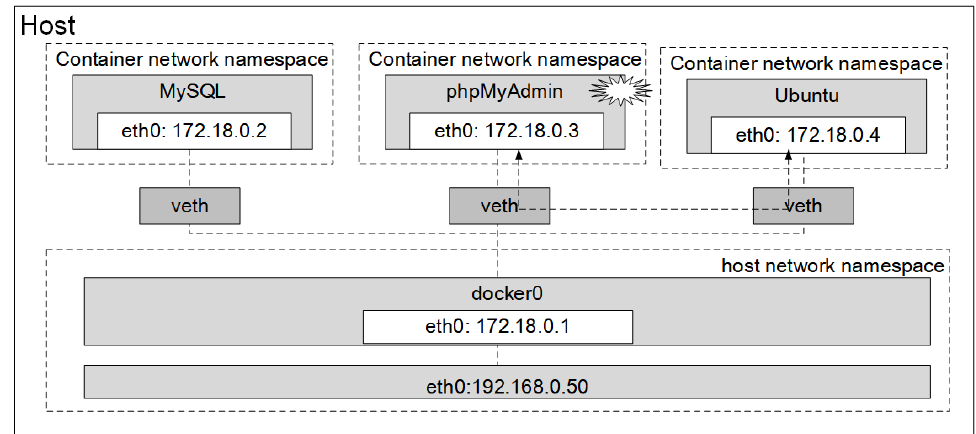
Figure 14. DDoS experimental environment.